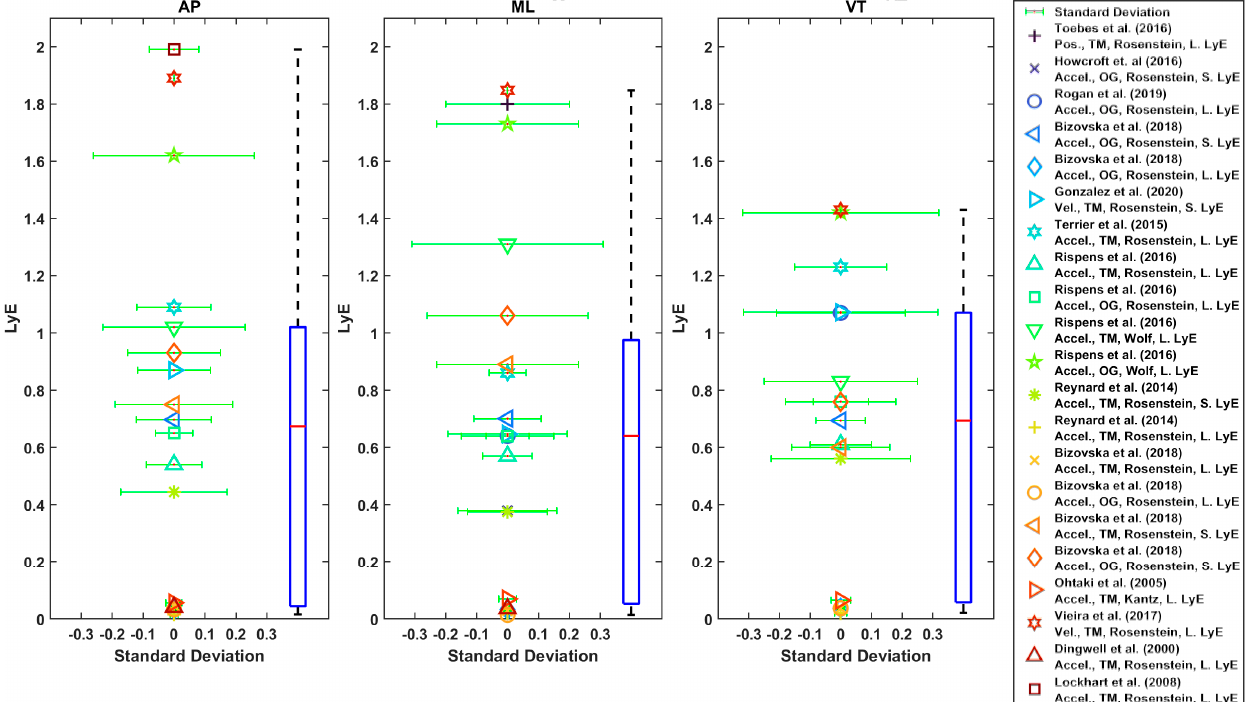
Figure 6. Reported Trunk Short-Term LyE or Long-Term LyE for healthy older adults.